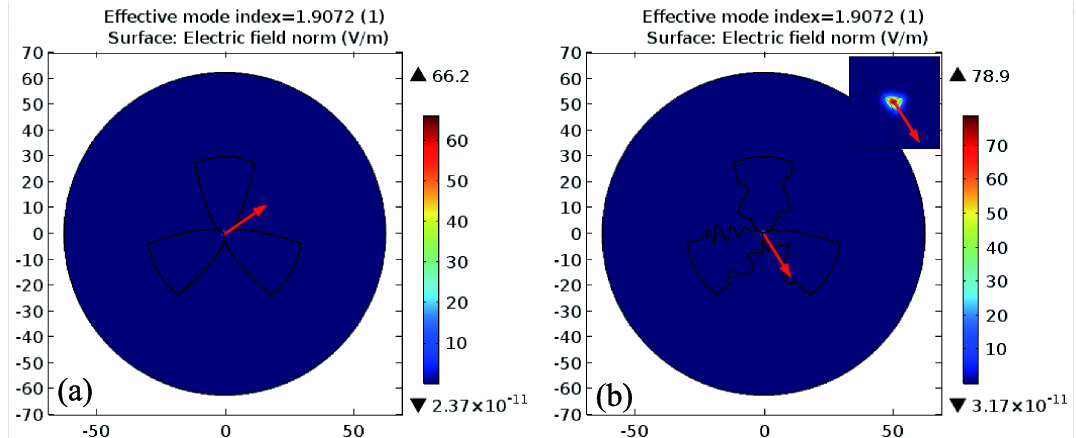
Figure 4. Influence of air-hole ( d = 1 µ m, a = 0.2 µ m − 1 ) with ( a ) perfect boundary ( b ) large defects on SCF’s the electric field distribution of FM and n eff .